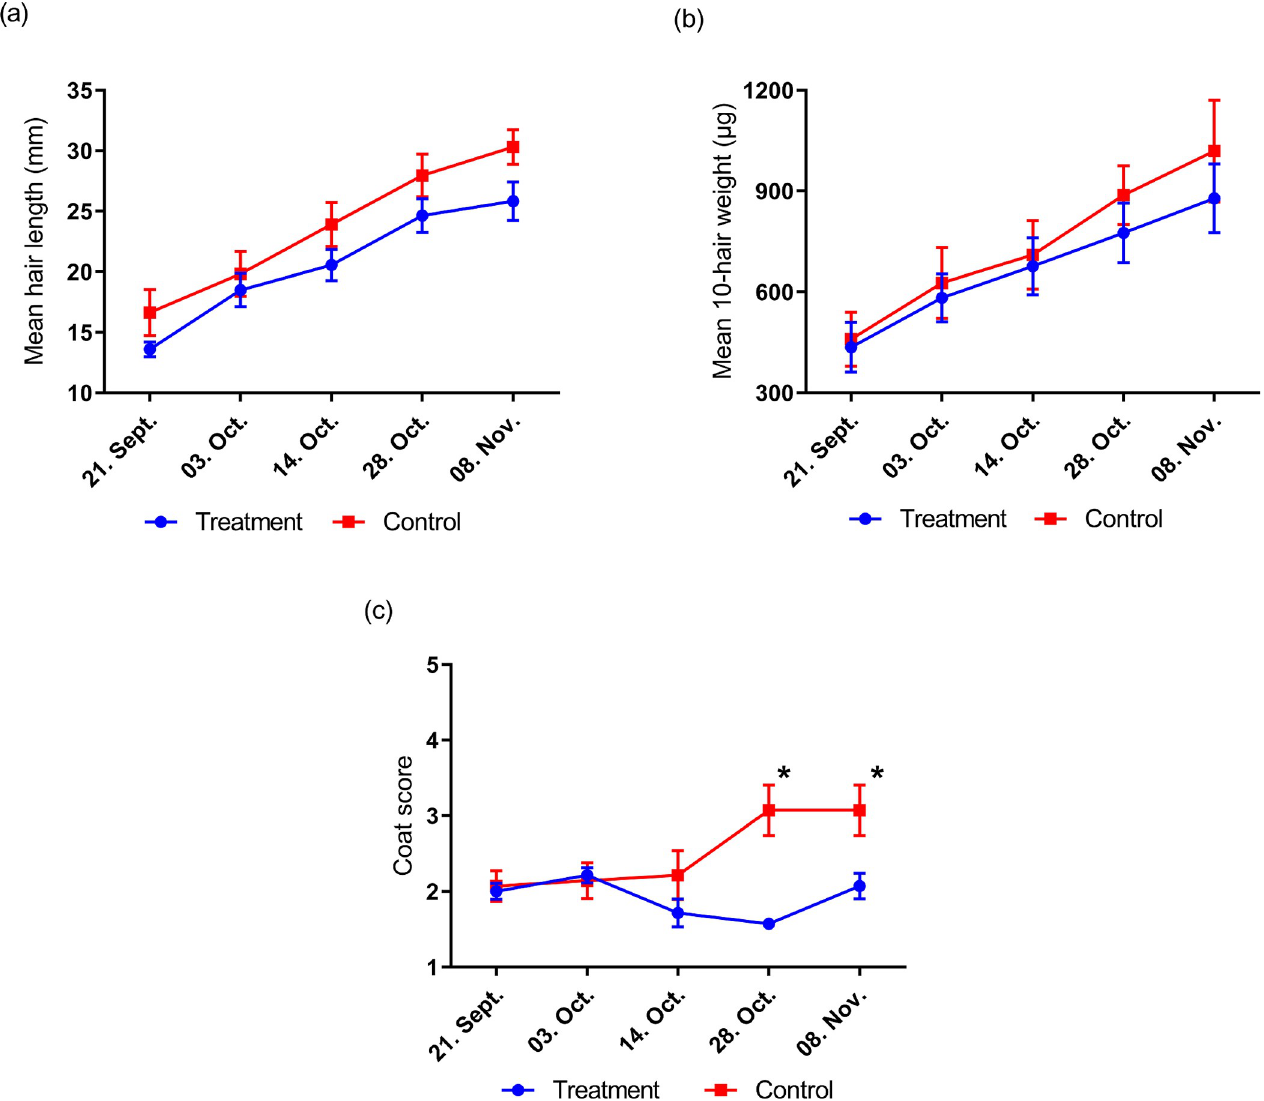
Fig 2. Changes in guard hair length (a), guard hair weight (b) and coat condition (c) of stabled horses and ponies in study 1. � denotes significance at P < 0.05.